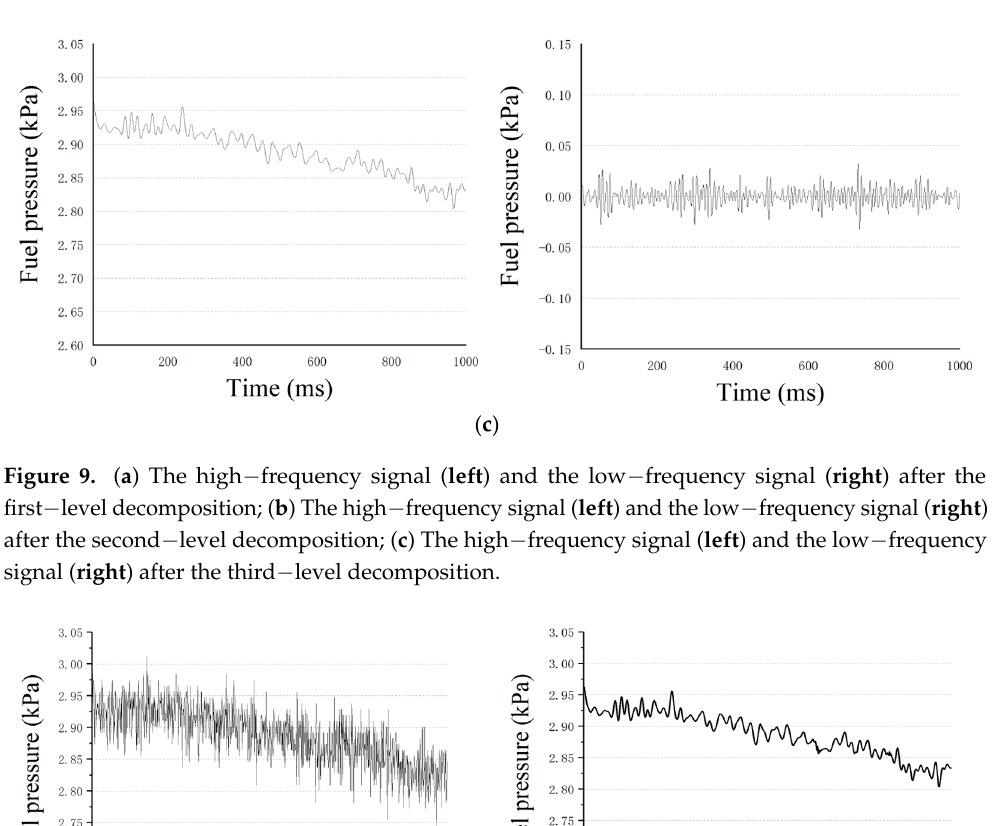
Figure 10. ( a ) Time series; ( b ) Low-frequency signal. The filtered small-amplitude high-frequency signal is shown in Figure 11.